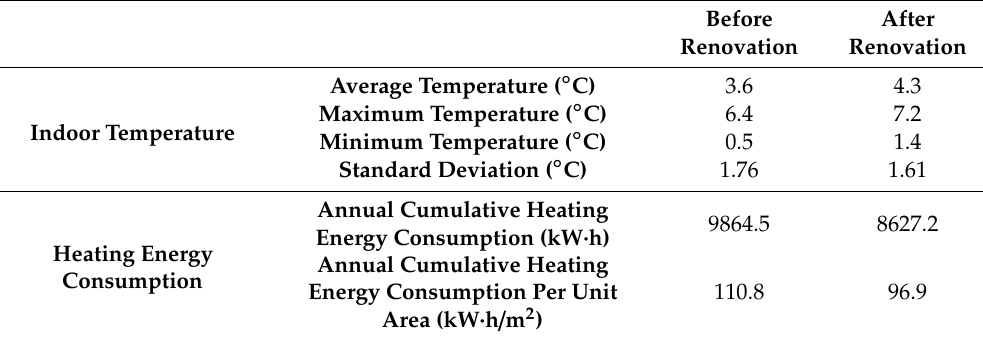
Figure 21. The annual cumulative heating energy consumption before and after renovation of doors and windows. Table 8. The data of temperature and energy consumption before and after renovation of doors and windows.